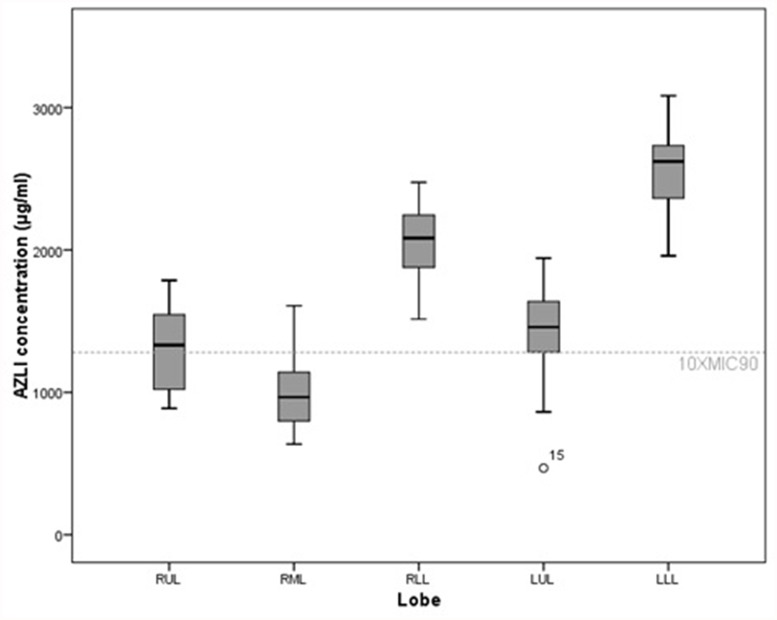
Differences between lobes in AZLI concentrations.Differences between lobes in AZLI concentrations for the scenario of thick airway surface liquid with largest aerosol diameter. Data are presented as median (range), unless otherwise indicated. Significant differences in AZLI concentrations were found between all lobes, except for one pairwise comparison (see S1 Table). RUL = right upper lobe, RML = right middle lobe. RLL = right lower lobe, LUL = left upper lobe, LLL = left lower lobe.